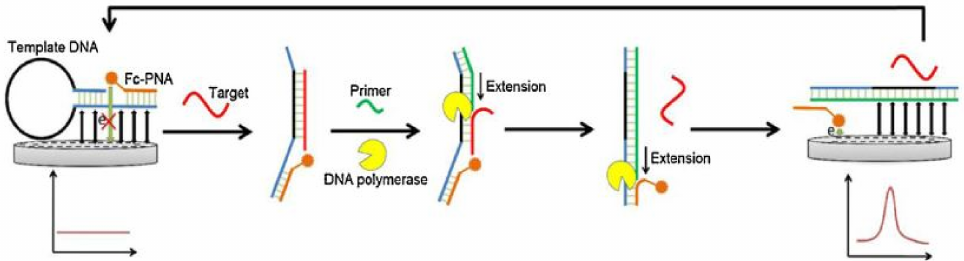
Figure 27. The mechanism of Fc-PNA combined signal-amplified electrochemical DNA sensor based on isothermal circular strand-displacement polymerization reaction. Reprinted with permission from reference [90]. Copyright 2012 Elsevier